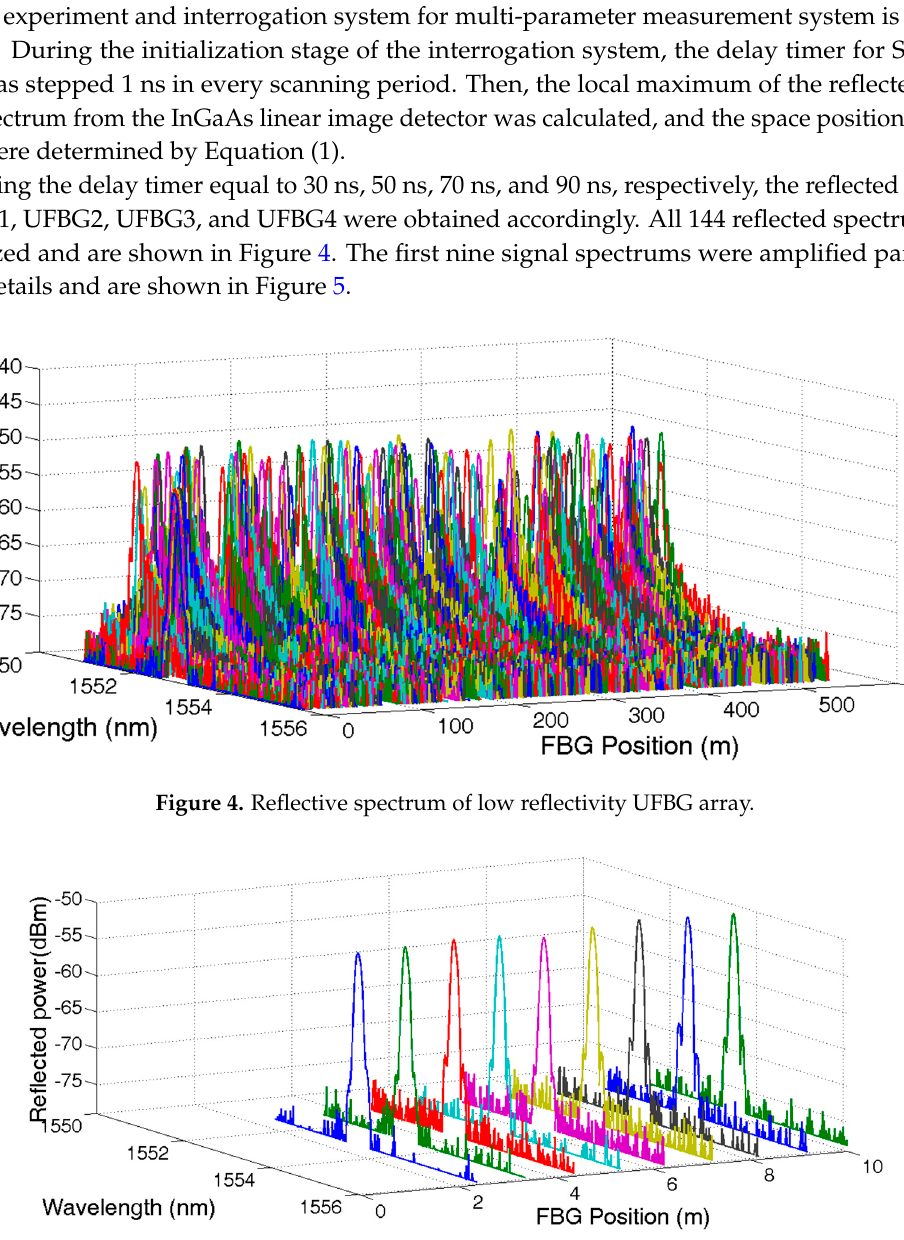
Figure 5. Reflective spectrum of UFBG1~UFBG9.